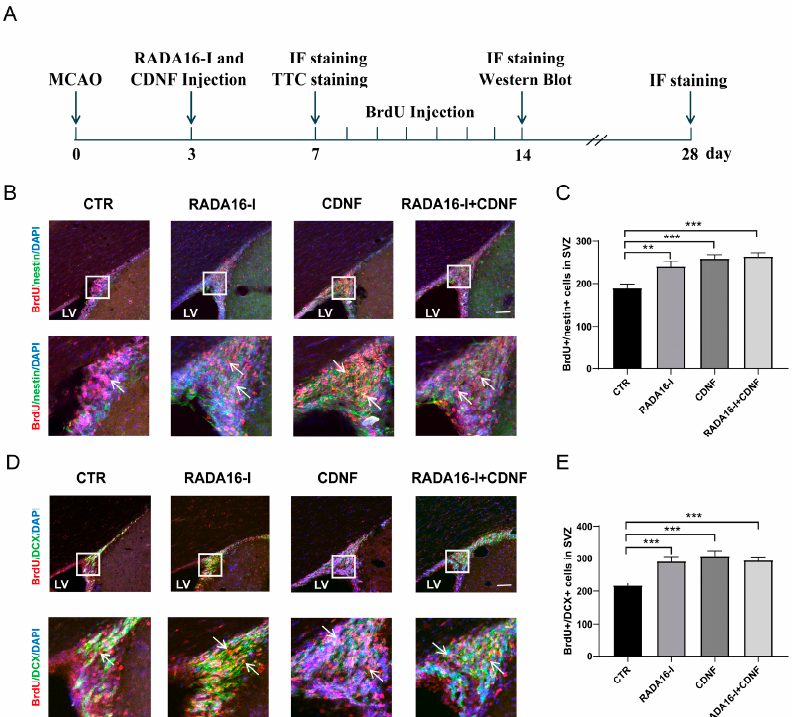
Figure 3. RADA16-I and CDNF promoted the proliferation of NSCs and neuroblasts in the SVZ of MCAO rats. ( A ) Experimental scheme of treatment with RADA16-I and CDNF in the MCAO rats. ( B ) RADA16-I and CDNF significantly increased the number of BrdU (red)/nestin (green)-positive cells in the SVZ two weeks after MCAO. DAPI (blue) was used to label the nuclei. The insets show photomicrographs of the SVZ at higher magnification. Arrows point to the BrdU/nestin-positive cells. ( C ) Quantitative analysis of BrdU/nestin-positive cells in the SVZ. ( D ) RADA16-I and CDNF significantly increased the number of BrdU (red)/DCX (green)-positive cells in the SVZ. DAPI (blue) was used to label the nuclei. The insets show photomicrographs of the SVZ at higher magnification. Arrows point to the BrdU/DCX-positive cells. ( E ) Quantitative analysis of BrdU/DCX-positive cells in the SVZ. Every sixth section of whole SVZ in each rat was collected for staining. N = 5/group. ** p < 0.01, *** p < 0.001 according to ANOVA followed by LSD post hoc analysis. Scale bar = 45 µm. LV, lateral ventricle.